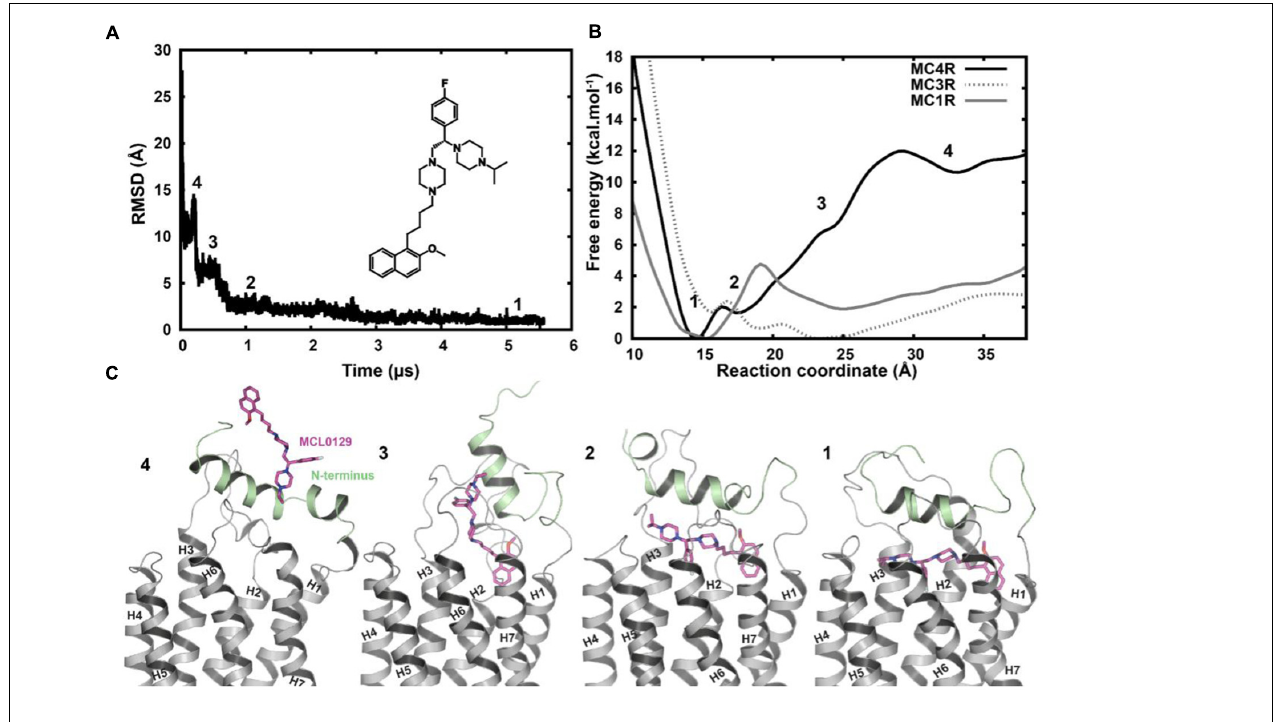
FIGURE 3 | (A) Root-mean-square deviation of MCL0129 binding to hMC4R with a scheme for the structure of the non-peptidic antagonist MCL0129. (B) Free-energy profile for MCL0129 binding to hMC1R, hMC3R, and hMC4R with (C) representatives structures for the observed binding steps at MC4R (states